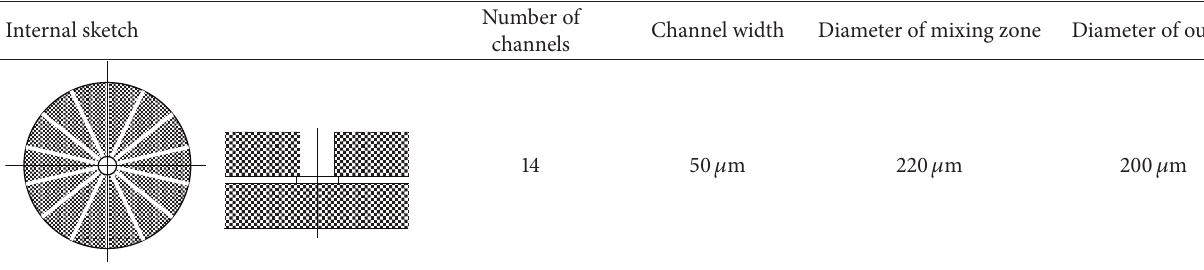
Table 1: Dimensions of KM micromixer.